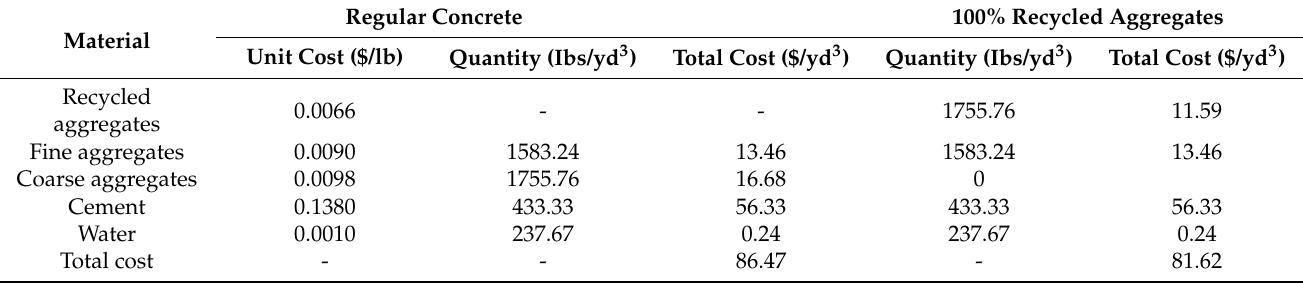
Table 5. Cost comparisons of conventional concrete and RAC per $/yd 3